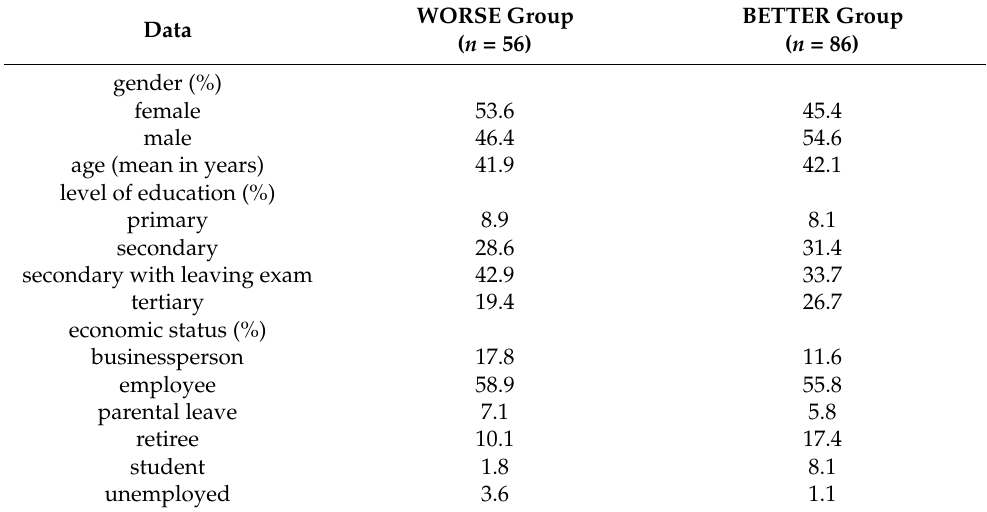
Table 2. Characteristics of